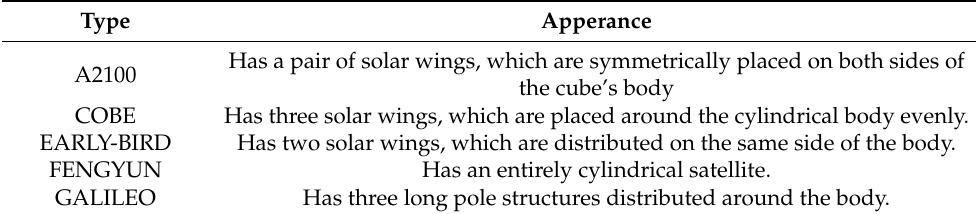
Table 1. The description of the satellites in BUAA-SID-POSE